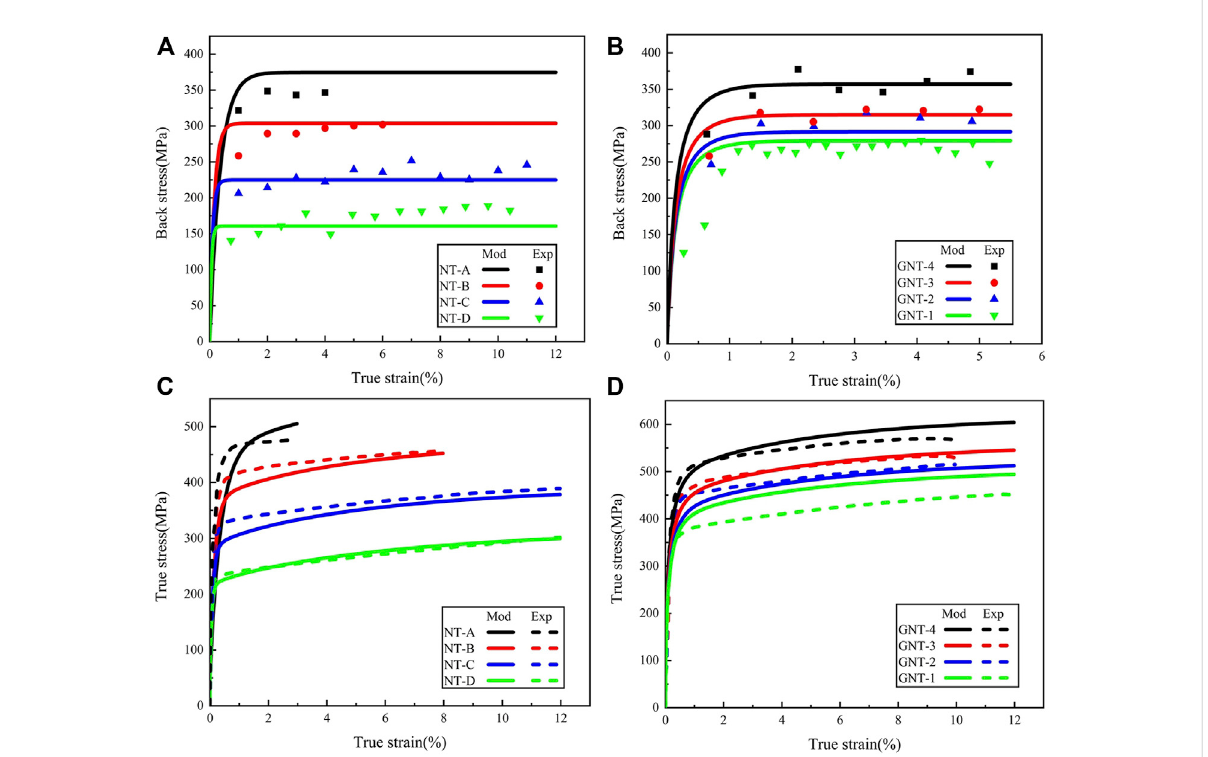
FIGURE 9 Mechanical properties of samples from modeling results and previous experiment. (A) Back stress-true strain curves of NT metals. (B) Back stress-true strain curves of GNT metals. (C) Tensile true stress-true strain curves of NT metals. (D) Tensile true stress-true strain curves of GNT